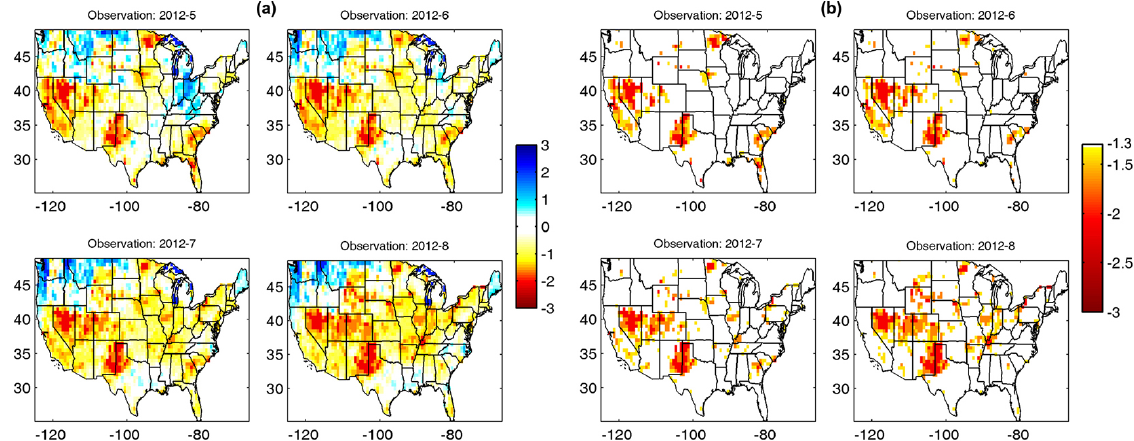
Figure 2. (a) Observed 6-month SSI for May–August 2012; (b) observed 6-month SSI with severe drought condition (SSI < − 1 . 3) for May–August